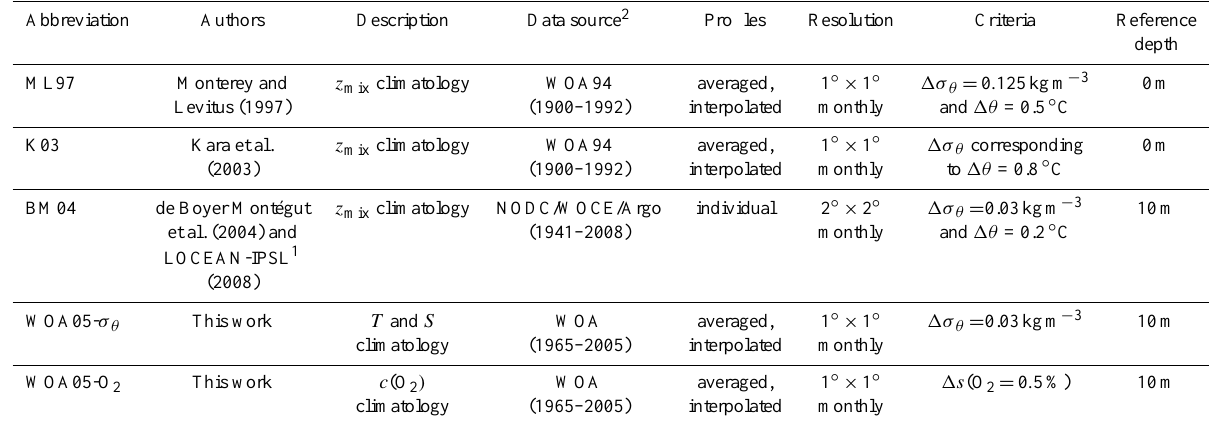
Table 1. Climatologies used in this work to compare with the mixed layer depths extracted from O 2